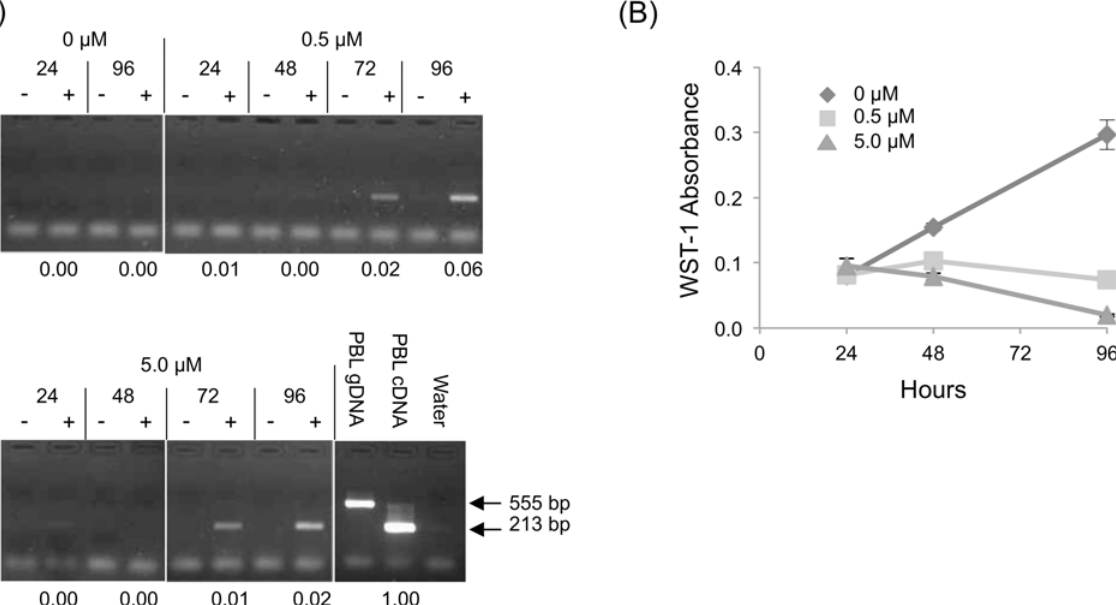
Fig 2. TES promoter demethylation and decreased NALM6 cell viability after decitabine exposure. NALM6 cells were exposed to decitabine (0, 0.5 and 5.0 μ M) for 24, 48, 72 and 96 hours. (A) TES qualitative RT-PCR: total RNA was mock (-) or reverse transcribed (+) before TES -specific amplification with exon-specific primers (exons 5 and 6). Expected PCR product sizes for cDNA and genomic DNA were 213 bp and 555 bp, respectively. TES expression levels, as measured by quantitative RT-PCR assay and calculated relative to PBL cDNA, are recorded under each lane. (B) Viable NALM6 cell number was measured by WST-1 assay (error bars are standard deviations).